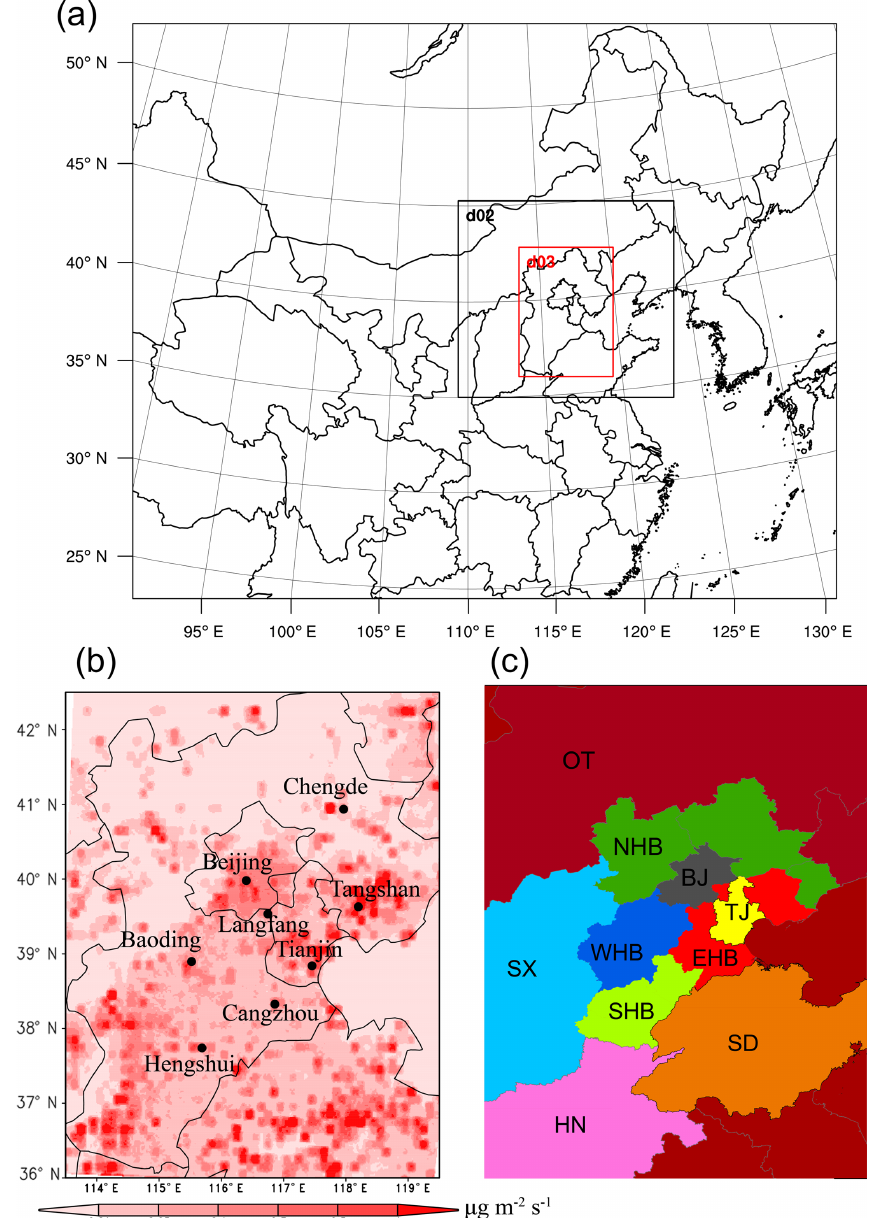
Figure 1. (a) Simulation domains: “do2” represents the second domain, and “d03” represents the third domain. (b) Primary PM 2 . 5 emission rates of the innermost domain and locations of observation sites (black dots). (c) Tracer tagging regions that are described in Table